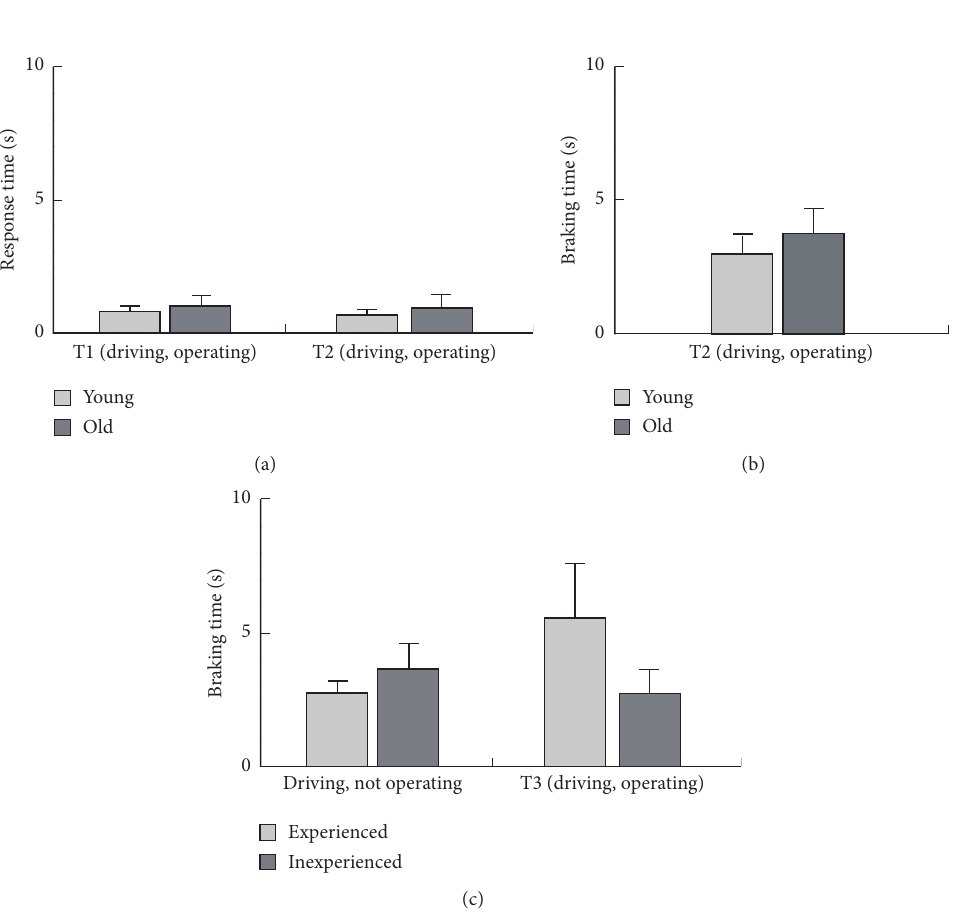
Figure 7: Impact of age and experience on response time and braking stop time. (a) The response time and (b) the braking stop time of different ages while operating car-sharing software. (c) The braking stop time of experienced and inexperienced drivers while driving with car-sharing